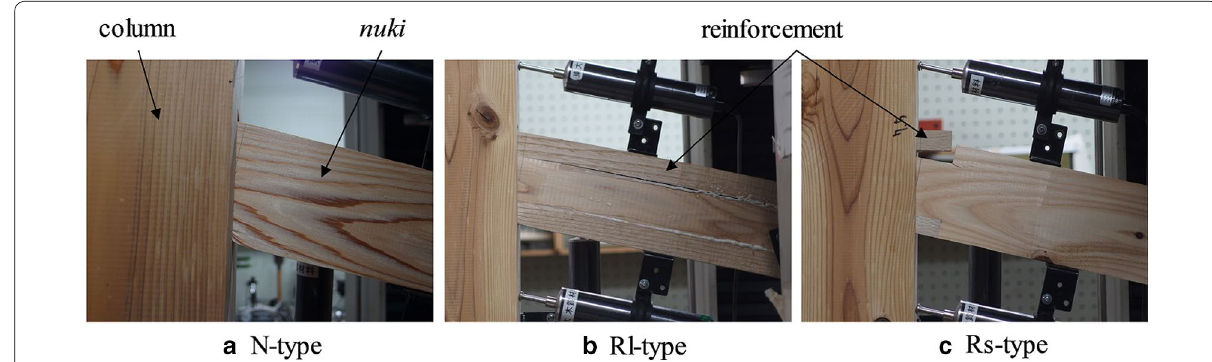
Table 1 Summary of the rotation tests results of N types